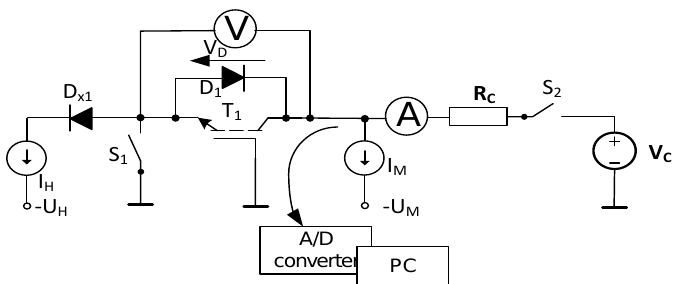
Figure 3. Measurement set-up to determine transient thermal impedance Z thT (t) of the IGBT with the use of the gate-emitter voltage as a thermally sensitive parameter.